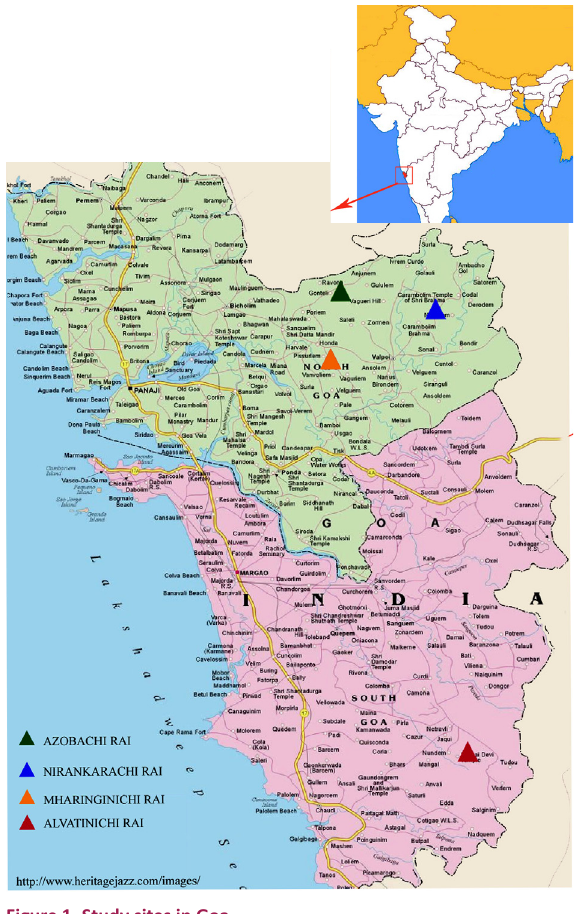
Figure 1. Study sites in